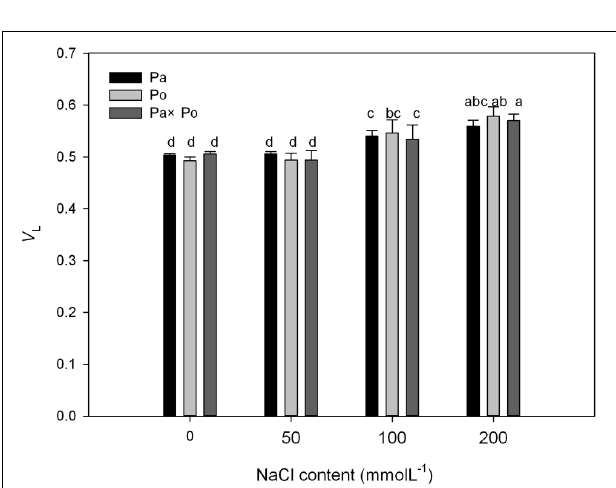
FIGURE 6 | The effect of salt stress on the standardized O–J curves and V k of leaves from the three P. amurensis sample types. Pa, P. amurensis Maxim ( P. opulifolius “Diabolo” ( ); Pa × Po, P. amurensis Maxim ( ) × P. opulifolius “Diabolo” ( ). Data in the figure are mean ± SE; values followed by different lowercase letters indicate a significant difference ( p < 0.05). ♂ ♀ ♂